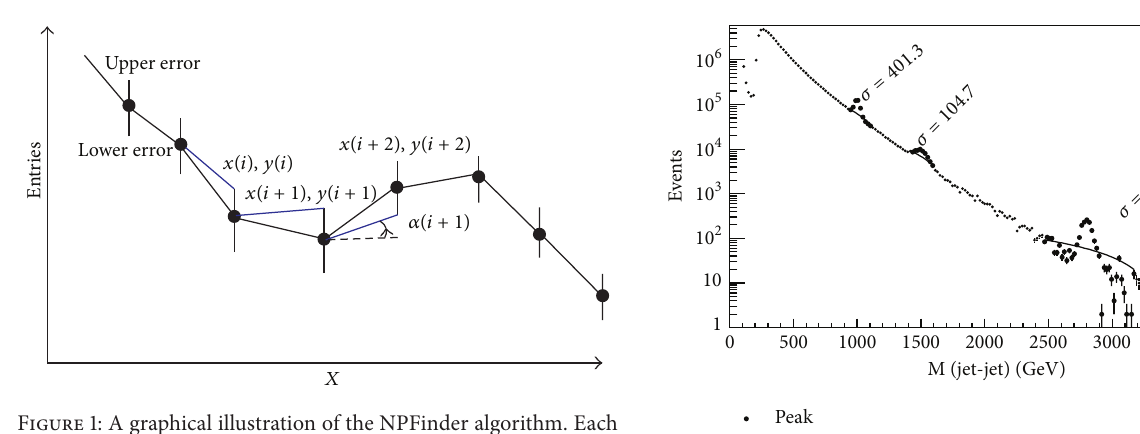
Figure 1: A graphical illustration of the NPFinder algorithm. Each data point is characterized by a coordinate (𝑥 𝑖 ,𝑦 𝑖 ) , with (optional) upper and lower uncertainties on the 𝑦 𝑖 values. See (1) for the definition of the slopes 𝛼 𝑖 .